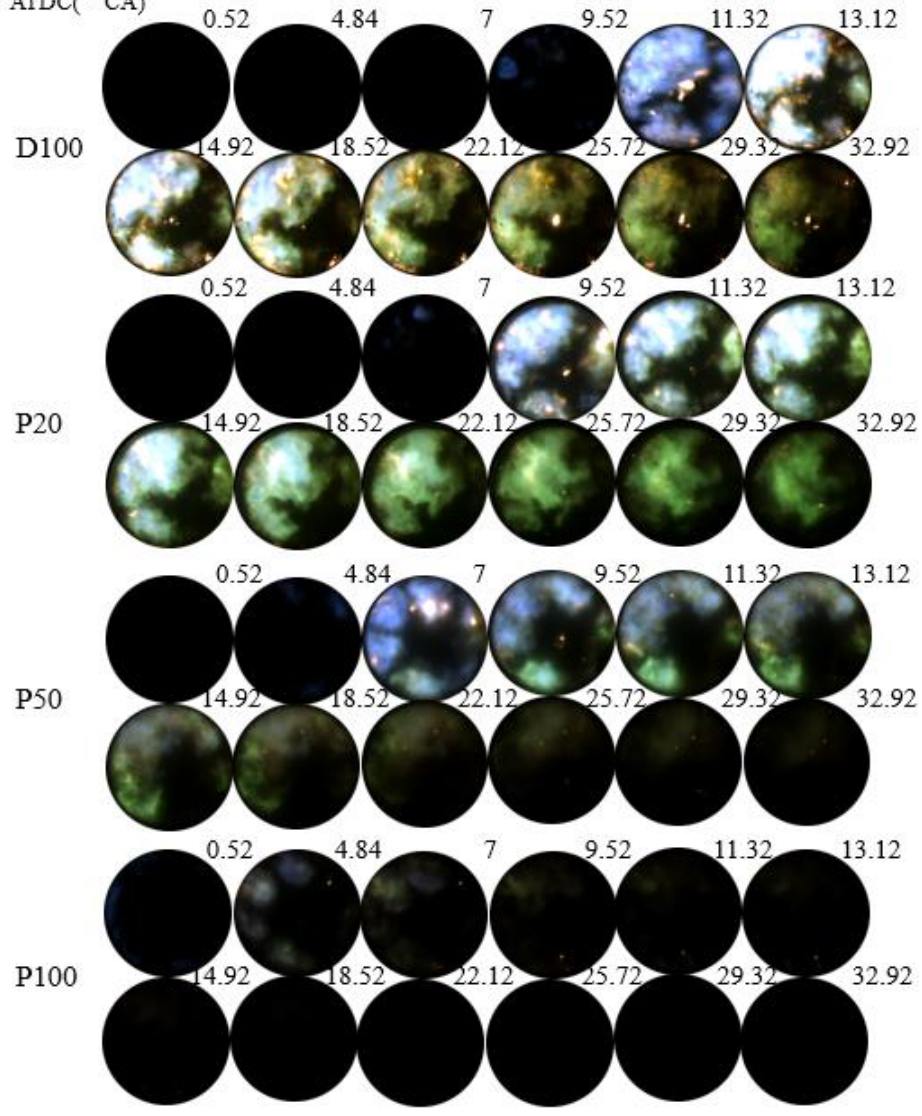
Figure 4. The combustion images (Injection pressure: 100 MPa; Injection timing: 6 °CA BTDC). The natural flame luminosity of fuels during combustion is mainly divided into chemiluminescence and soot incandescence, and the intensity of soot incandescence is much stronger than that of chemiluminescence [43]. It is generally believed that the “blue flame” symbolizes the chemiluminescence of HCHO converting into CO in high-temperature areas, and the “yellow flame” represents the incandescent light of soot [44,45]. The yellow flame of the blends decreased with the increasing of the PODE ratio in the blends, and almost no yellow flame was observed in the flames of P100. This was mainly due to the fact that PODE does not contain C-C bonds and has a high oxygen content, which had a positive effect on inhibiting soot formation. It should be noted that